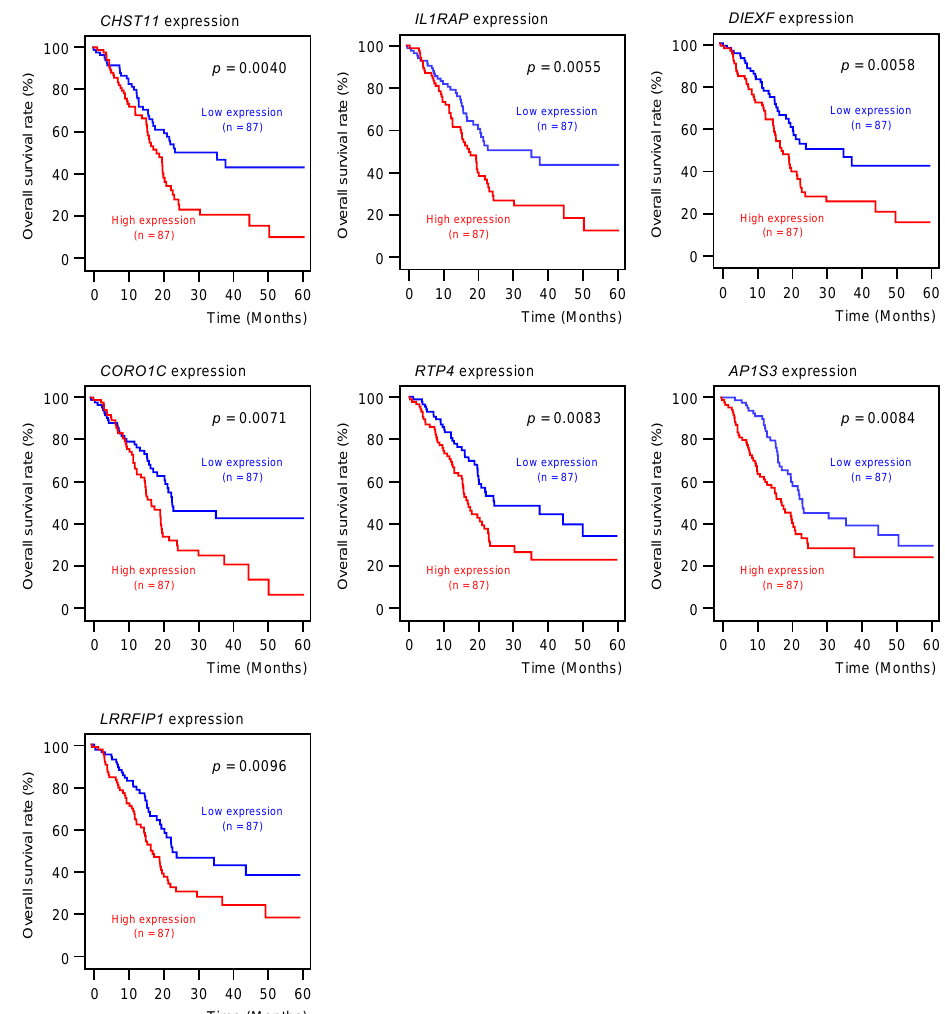
Figure 3. Clinical significance of miR-30c-5p and miR-30c-2-3p target genes by The Cancer Genome Atlas (TCGA) database analysis. Among the putative target genes of miR-30c-5p and miR-30c-2-3p regulation in PDAC cells, high expression levels of 18 genes ( YWHAZ , CBFB , F3 , TMOD3 , NFE2L3 , ENDOD1 , ITGA3 , RRAS , PRSS23 , TOP2A , BHLHE40, CHST11, IL1RAP, DIEXF, CORO1C, RTP4, AP1S3 , and LRRFIP1 ) were found to significantly predict worse prognoses in patients with PDAC ( p < 0.01). Kaplan–Meier curves of the 5-year overall survival rate for each gene are presented.